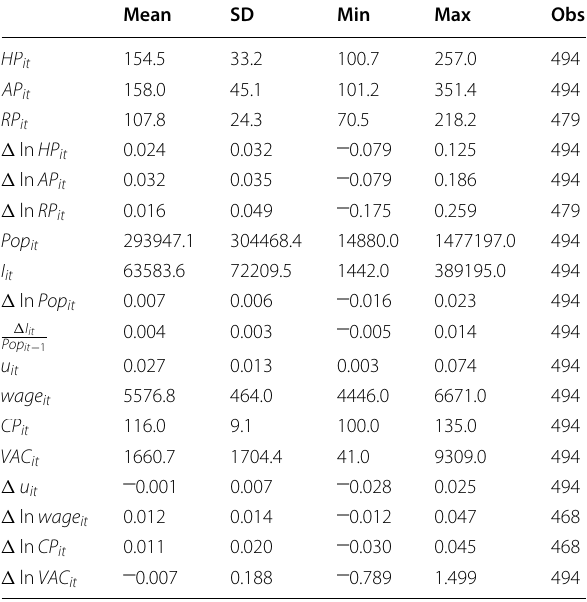
Table 3 Descriptive statistics at cantonal level, 1998–2016. Source: Own calculations based on data from Wüest Partner and Federal Statistical